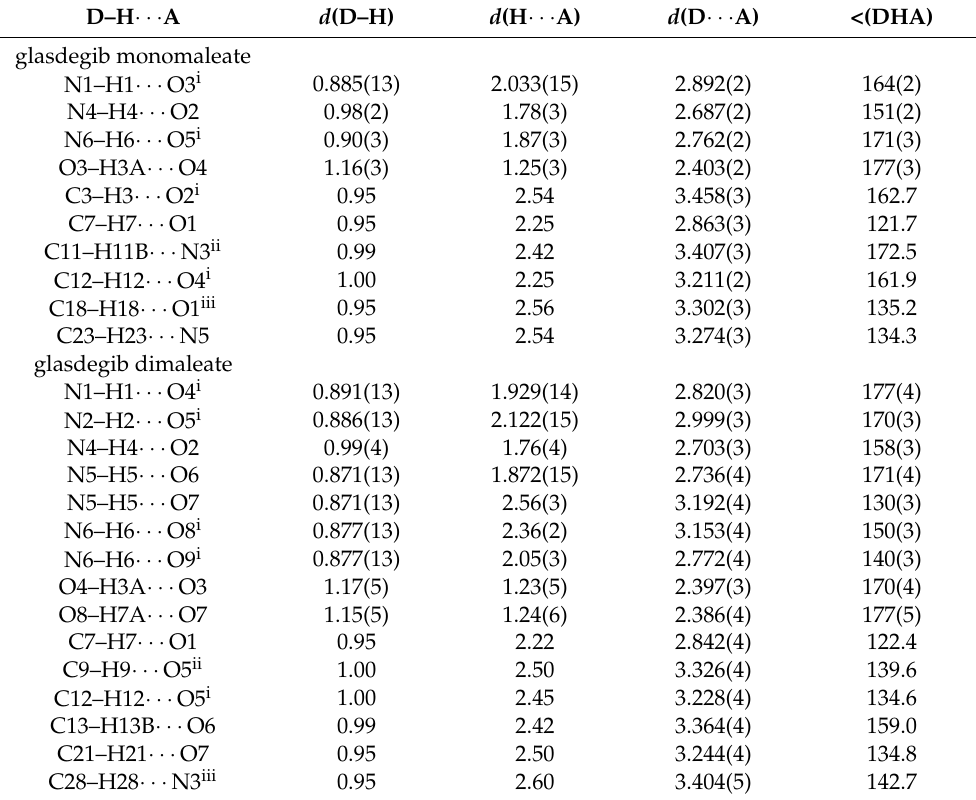
Table 2. Hydrogen bonds for glasdegib monomaleate and glasdegib dimaleate [Å and ◦